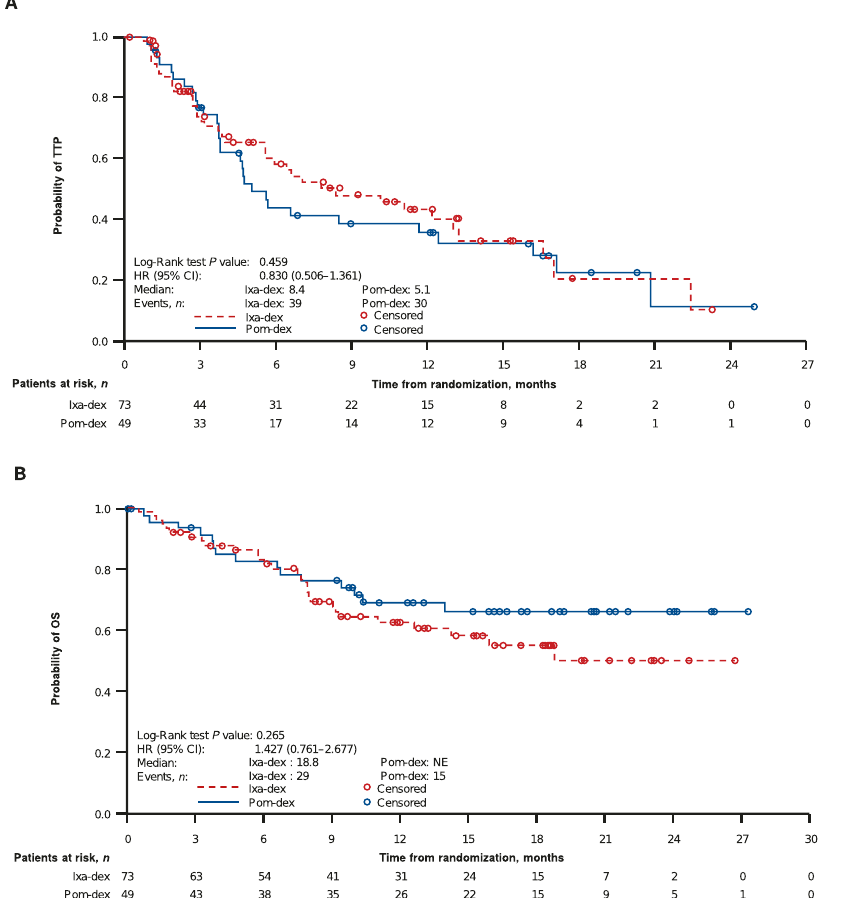
Fig. 3 Kaplan – Meier analysis of TTP and OS with ixa-dex vs pom-dex in the ITT population. A TTP and ( B ) OS. CI con fi dence interval, dex dexamethasone, HR hazard ratio, ITT intent-to-treat, ixa ixazomib, NE not estimable, OS overall survival, pom pomalidomide, TTP time to